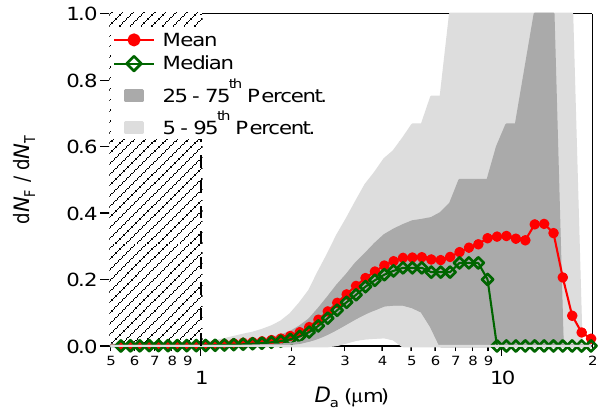
Fig. 12. Average size distribution of the FBAP to TAP number con- centration ratio (d N F /d N T ) for the entire measurement period (plot analogous to Fig.